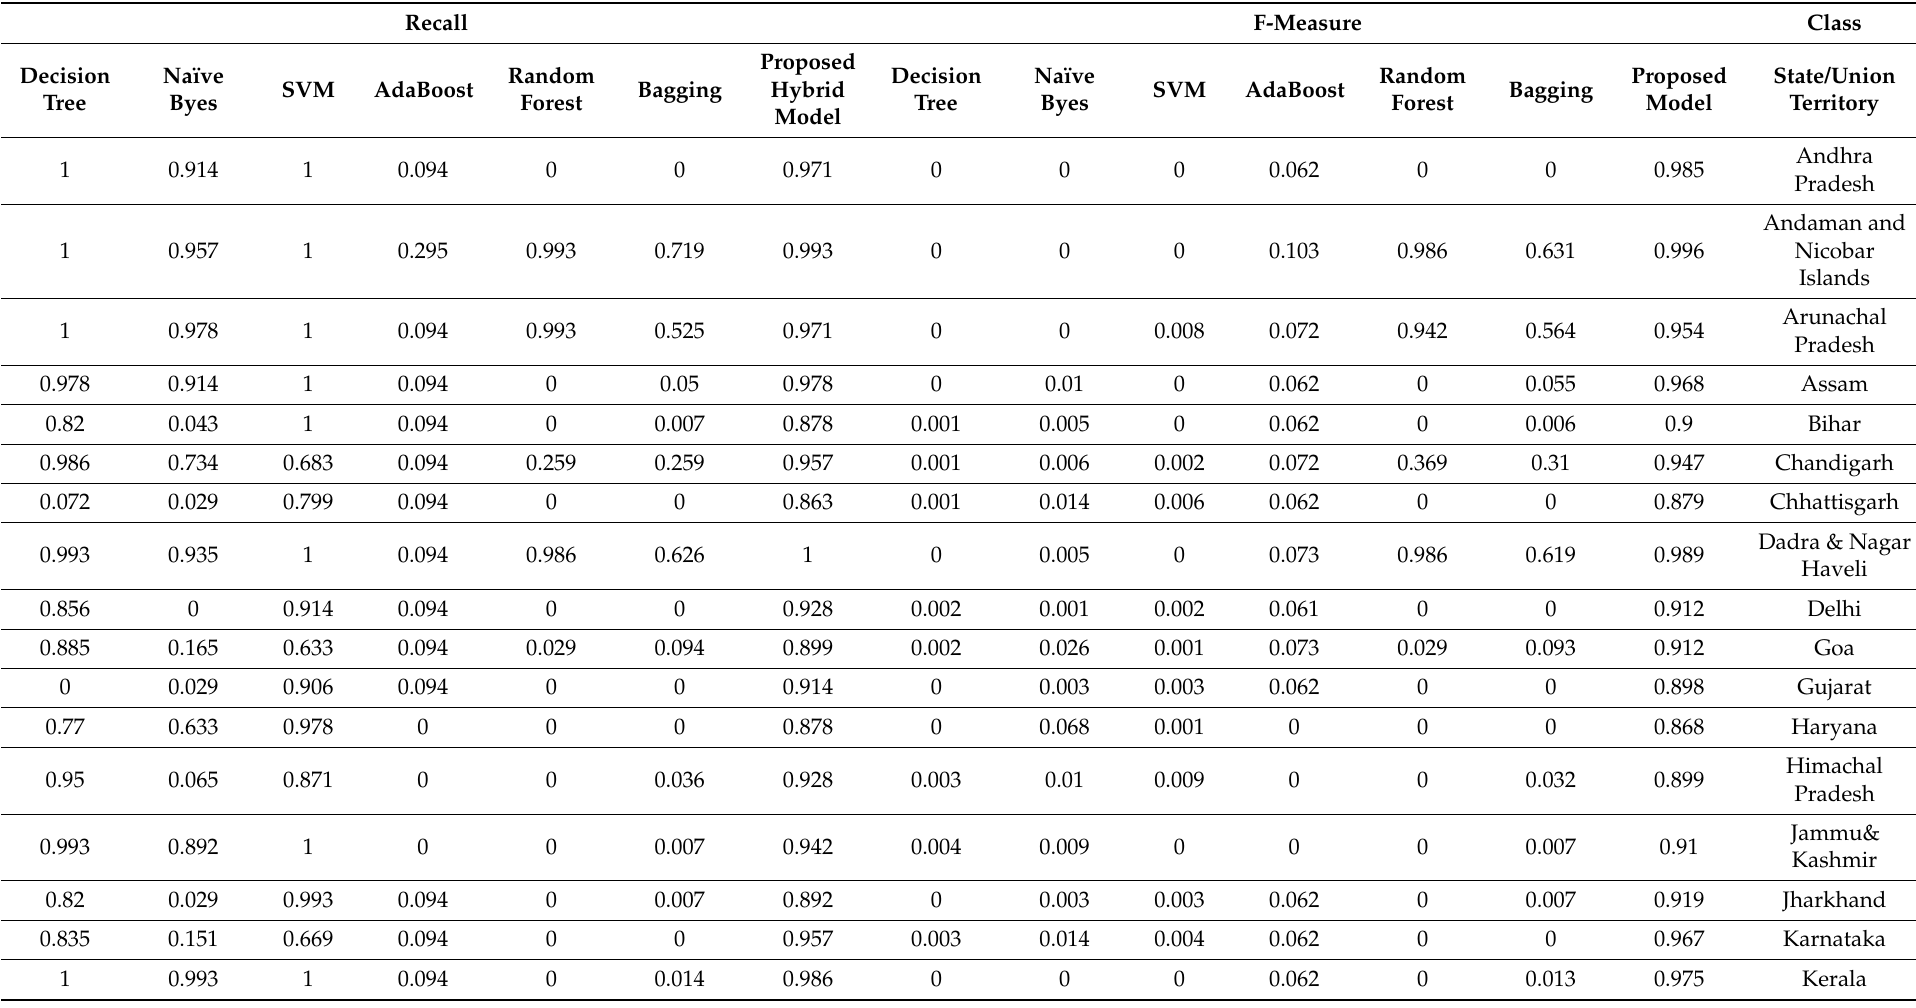
Table 6. Detailed Accuracy (Recall, F-Measure) for each class using Machine Learning